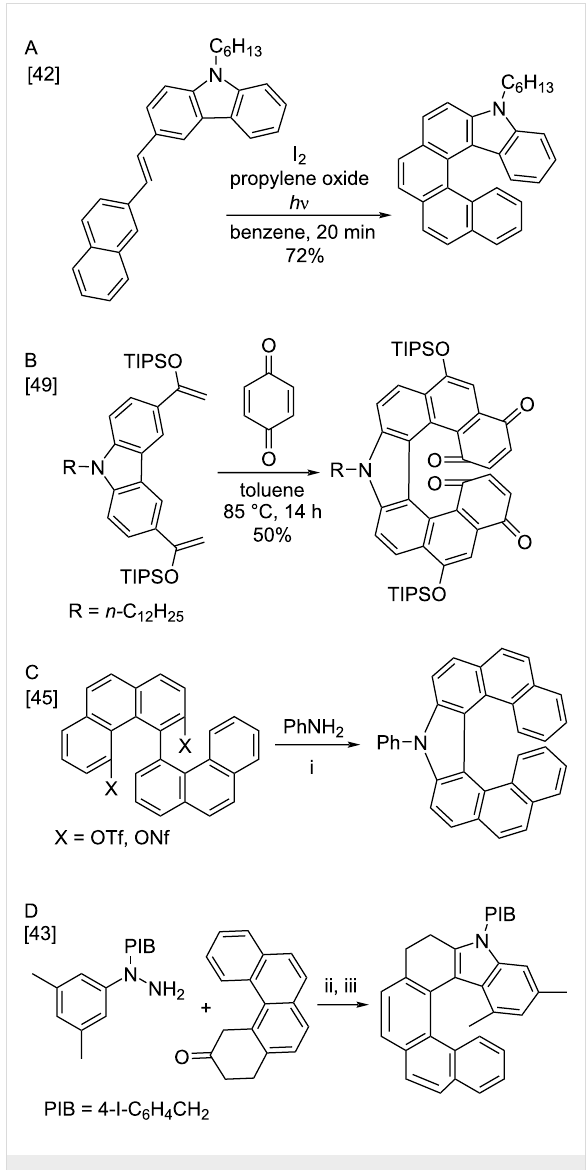
Scheme 1: Overview of the synthetic methods for the carbazole-based heterohelicenes. i) Pd 2 dba 3 , xantphos, K 3 PO 4 , xylene, 100 °C, 123 h, 64–88% ii) SPINOL-derived phosphoric acid, Amberlite CG50, CH 2 Cl 2 , − 7 °C, 72 h, 74%; iii) chloranil, diphenyl phosphate, CHCl 3 , 50